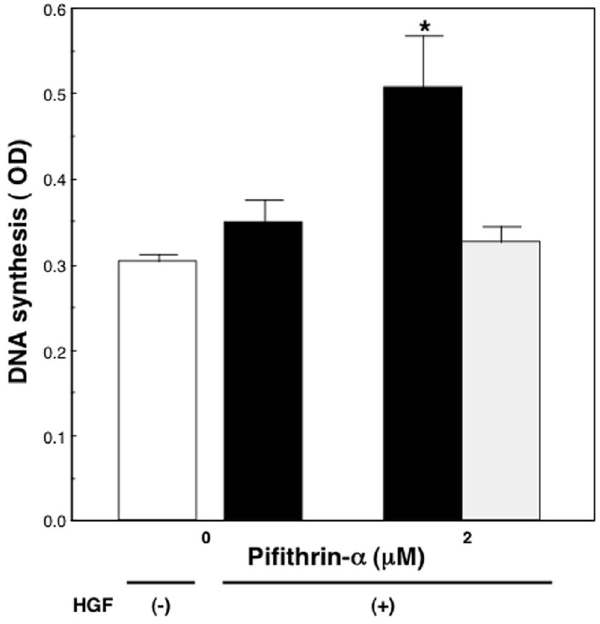
Figure 7. The effect of pifithrin- a on DNA synthesis of hepatocytes in the presence of HGF. Rat hepatocytes were cultured at high density in the same medium as described in the legend of Figure 6, except that the medium contained 1 mmol/L BrdU, for 24 hours. An open bar denotes hepatocytes cultured in the absence of HGF. Closed bars denote hepatocytes cultured with pifithrin- a in the presence of 10 ng/mL HGF. A dotted bar denotes hepatocytes cultured with DMSO in the presence of 10 ng/mL HGF. Data are mean 6 SEM of eight dishes. *p , 0.01 compared with the values treated only with HGF or values treated with HGF and DMSO.